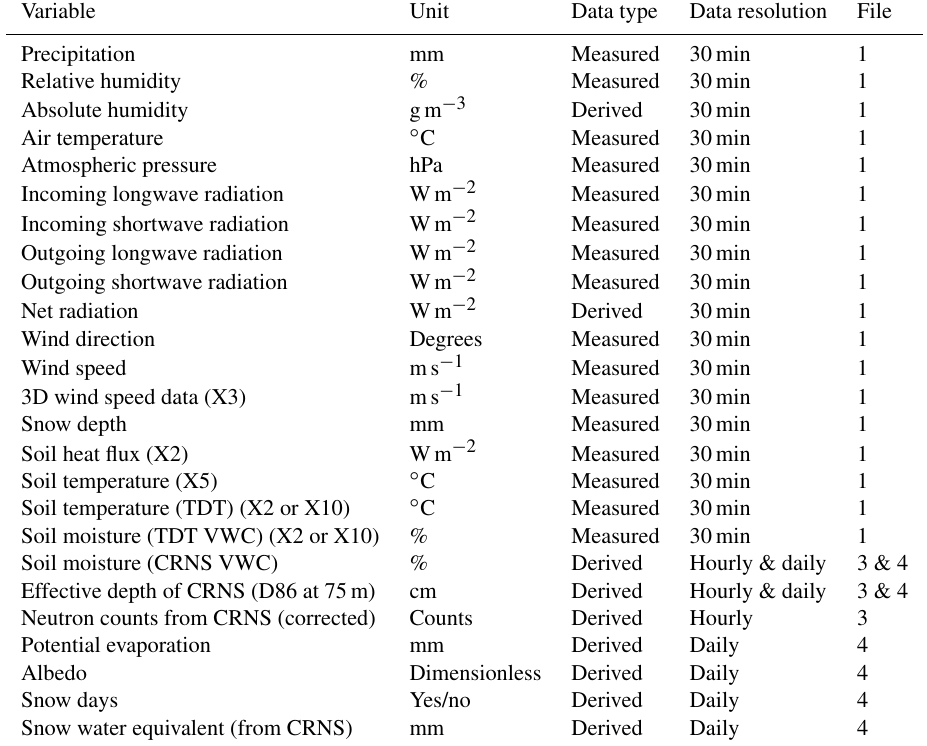
Table 7. Measured and derived variables available in the four data files provided in the COSMOS-UK dataset (Stanley et al., 2021).